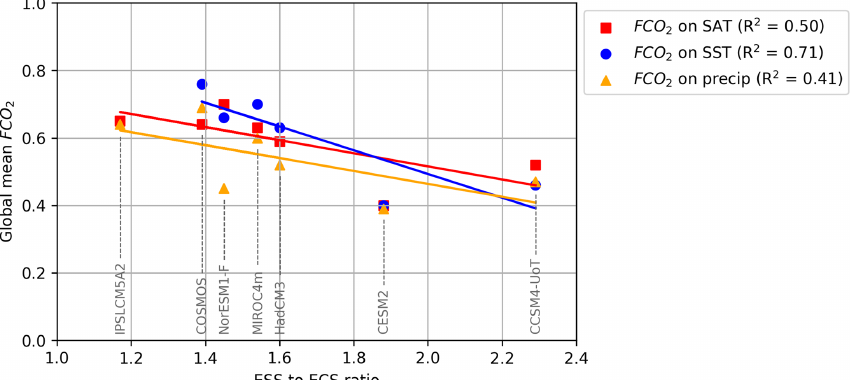
Figure 8. The relationship between the ESS-to-ECS ratio and global mean FCO 2 . IPSLCM5A2 is excluded from the SST analysis due to limited data